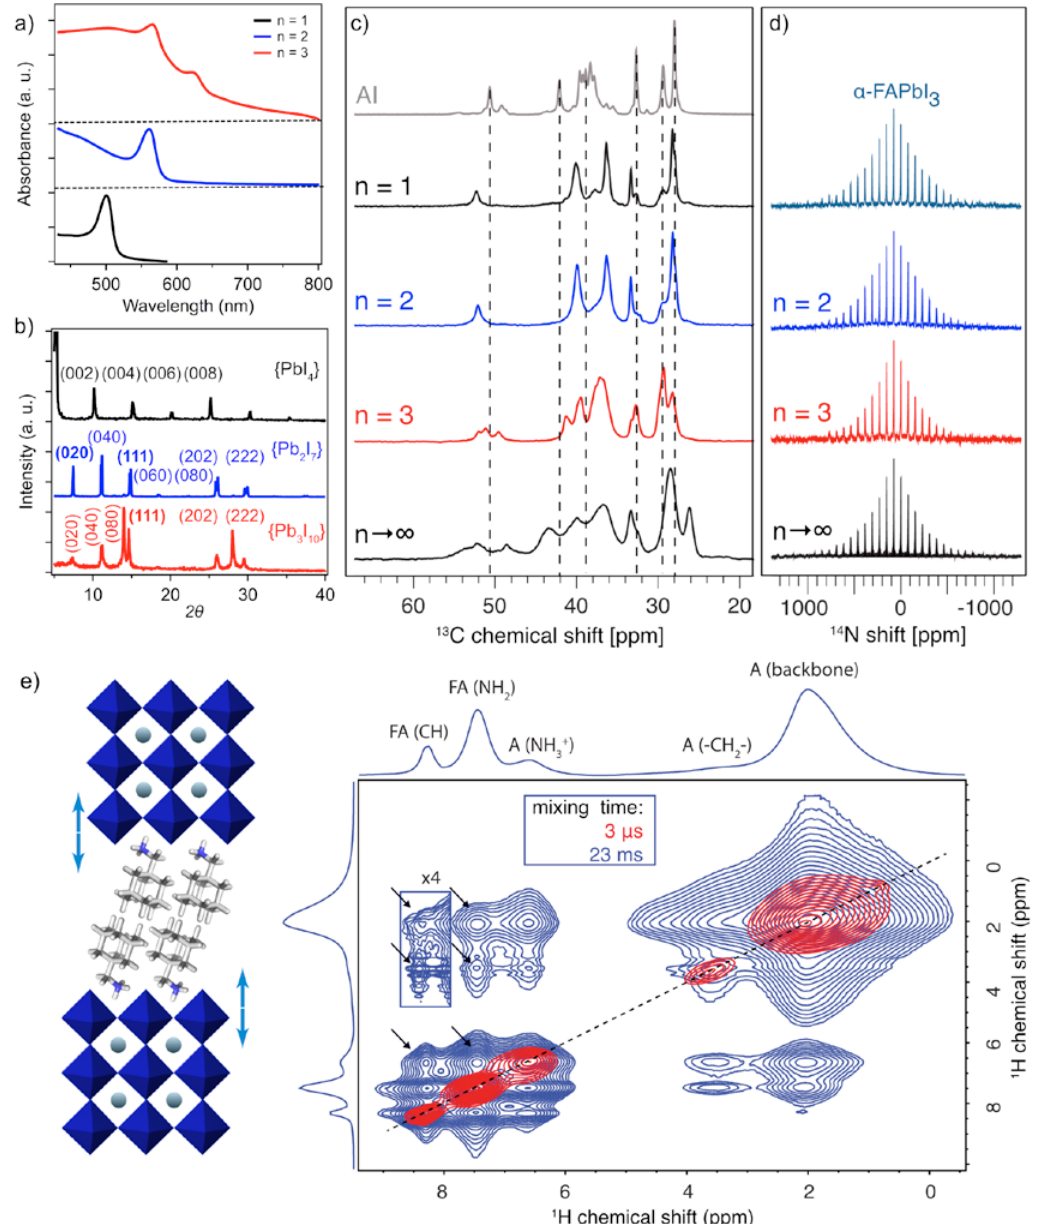
Figure 11. Hybrid layered perovskite Ruddlesden-Popper case. (a) UV-Vis absorption spectra spectra of three different A 2 FA n–1 Pb n I 3n+1 for- mulations (n = 1, 2, and 3). A = (adamantan-1-yl)methanammonium. (b) XRD patterns on glass substrates for thin films based on the A 2 FA n–1 Pb n I 3n+1 perovskite compositions (n = 1, 2, and 3). The indices of the corresponding planes are based on the Ruddlesden-Popper systems with comparable inorganic phases ({PbI 4 } for n = 1, {Pb 2 I 7 } for n = 2, and {Pb 3 I 10 } for n = 3). 31 (c) 13 C CP solid-state MAS NMR spectra at 21.1 T, 100 K, 12 kHz MAS in the spectral area of the spacer (between 20 and 60 ppm) of neat AI and mechanochemical A 2 FA n– 1 PbnI 3n+1 (n = 1, 2, 3, →∞) powders. The n→∞ system contains a 3D α-FAPbI 3 perovskite powder modulated with 3 mol% AI. (d) solid-state MAS NMR spectra at 21.1 T, 298 K, 5 kHz of neat α-FAPbI 3 and A 2 FA n–1 Pb n I 3n+1 (n = 2, 3, →∞). CP = cross-polarization; MAS = magic angle spinning. (e) Left: Schematic of the A 2 FA 2 Pb 3 I 10 composition. The arrows indicate the proximity between the FA cations and the backbone of the spacer, which provides a correlation observed by spin diffusion (SD) experiments. Right: 1 H- 1 H SD solid state MAS NMR spectra at 21.1 T, 298 K, 20 kHz MAS of mechanochemical A2FA2Pb3I10 using mixing times of 3 μs (red) and 23 ms (blue). The for- mulations are defined by the stoichiometry of the precursors and they include mixtures of phases for n > 2 compositions. The region inside a rectangle is magnified to highlight the low intensity cross-peaks. The black arrows show the cross-peaks that evidence atomic-level inter- action between FA and A. Adapted from ref. 87 with